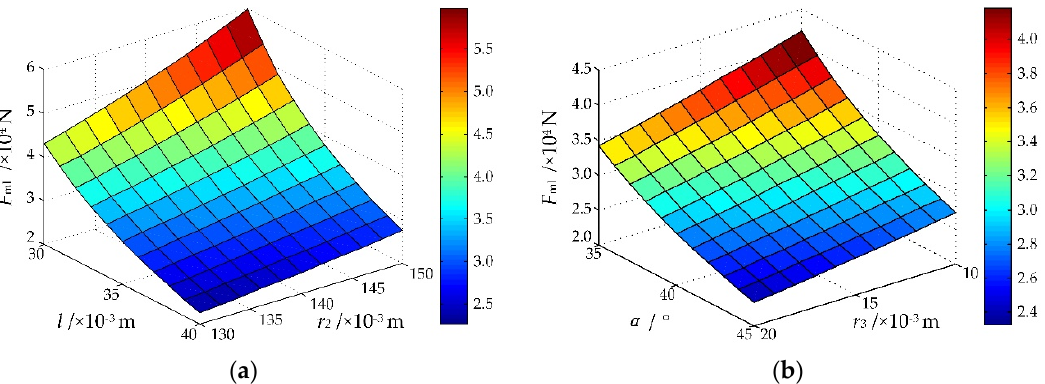
Figure 10. The lockable maximum load of the closing spring with ( a ) effects of r 2 and l ; ( b ) effects of r 3 and α .